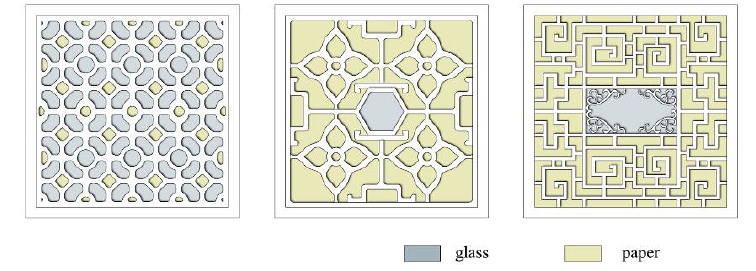
Figure 1: The traditional window frame in Tsing